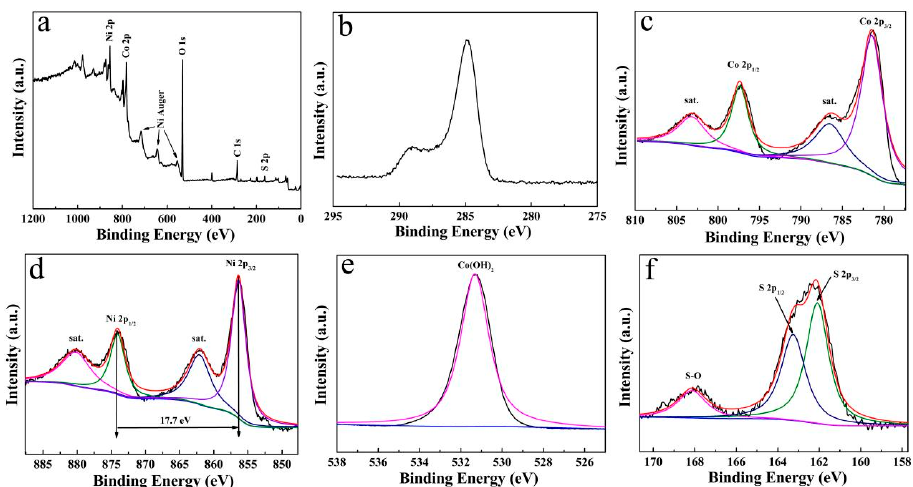
Figure 3. XPS spectra of ( a ) survey scan; ( b ) C 1s; ( c ) Co 2p; ( d ) Ni 2p; ( e ) O 1s; ( f ) S 2p of Co(OH) 2 /Ni 3 S 2 electrode.